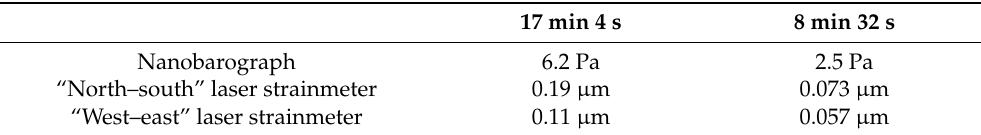
Table 3. Data of spectral processing of records of the laser-interference systems, installed at Schulz Cape, the second direct passage of Lamb waves near Schultz